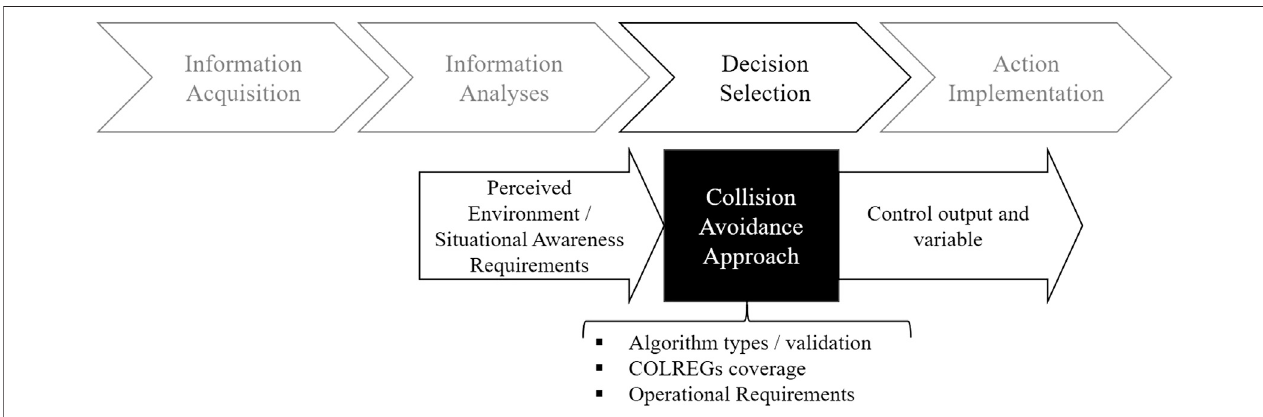
FIGURE 2 | Associations to collision avoidance in terms of